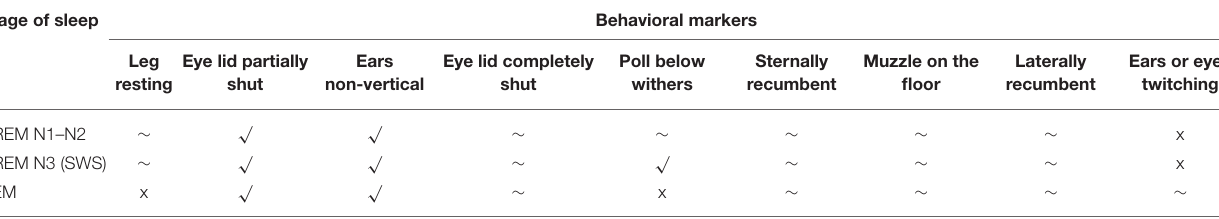
TABLE 4 | Behavioral markers of different EEG sleep states in the horse. Stage of sleep Behavioral markers Leg Eye lid partially Ears Eye lid completely Poll below Sternally Muzzle on the Laterally Ears or eyes resting shut non-vertical shut withers recumbent floor recumbent